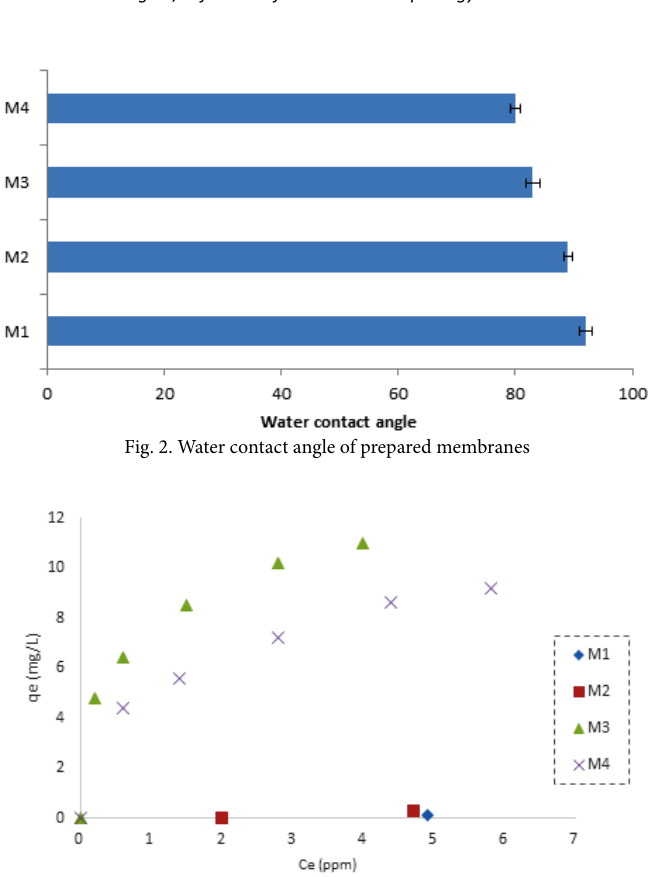
Fig. 3. The HA adsorption capacity for membranes with the different initial